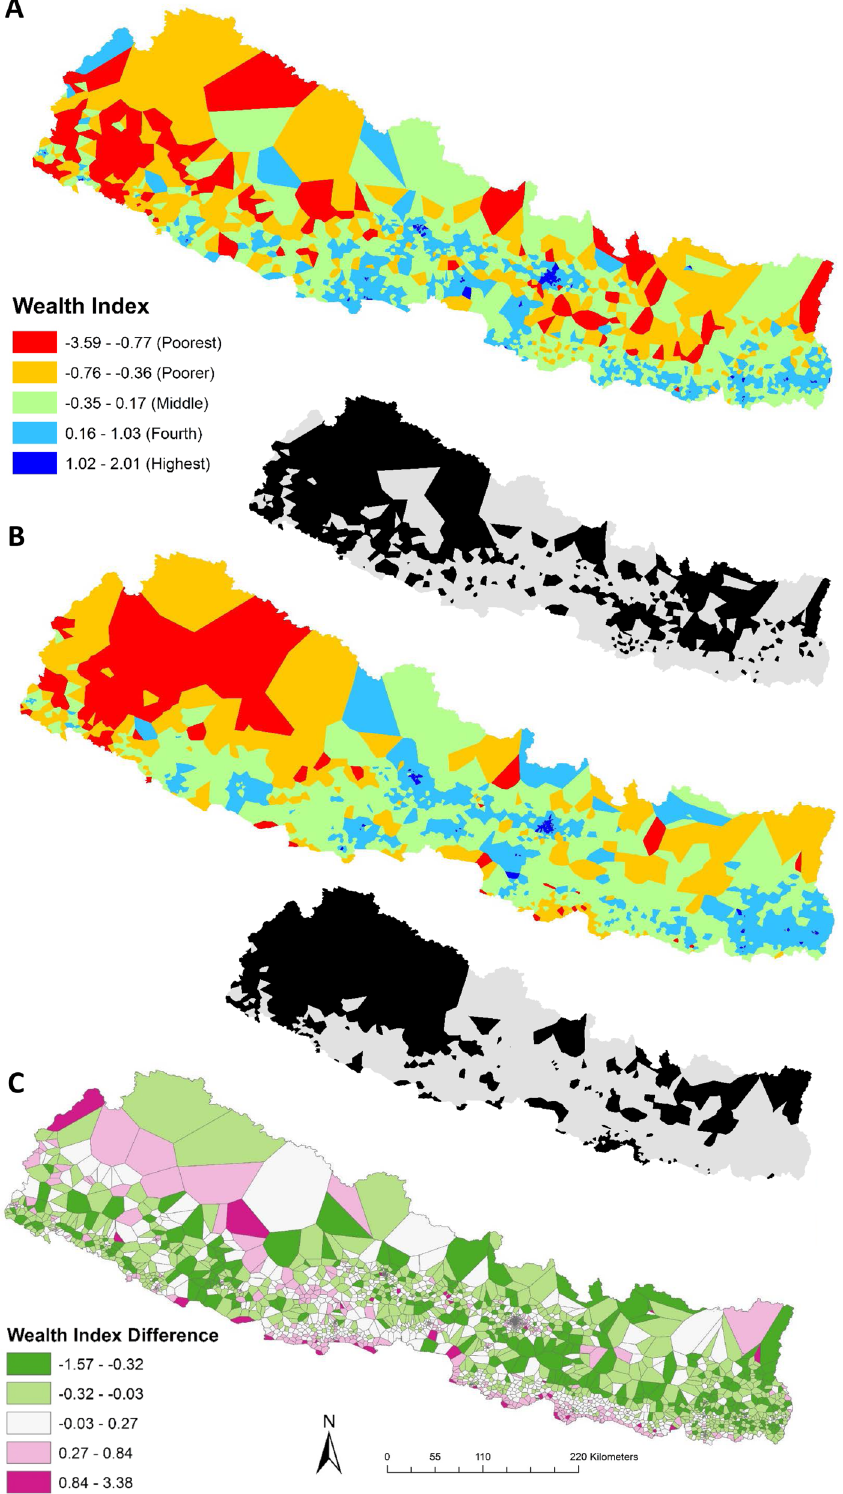
Fig. 5 National wealth index maps produced for Nepal. This fi gure shows maps produced using all available noncollinear CDR data ( A ), a CDR subset comprised of 5 generalizable features ( B ), and the difference between these two models ( C ). For ( A ) and ( B ), the subset maps show, in black, poor areas predicted by each model (the Demographic and Health Surveys class the two lowest quintiles, poorer and poorest, as poor).